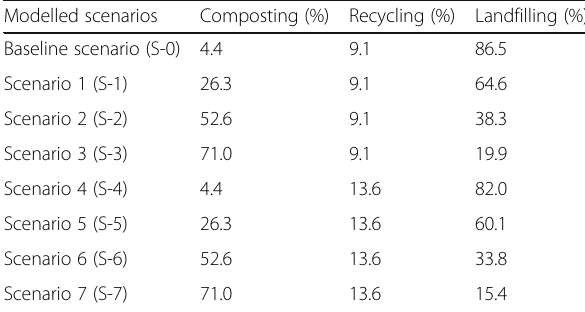
Table 3 Description of the modelled